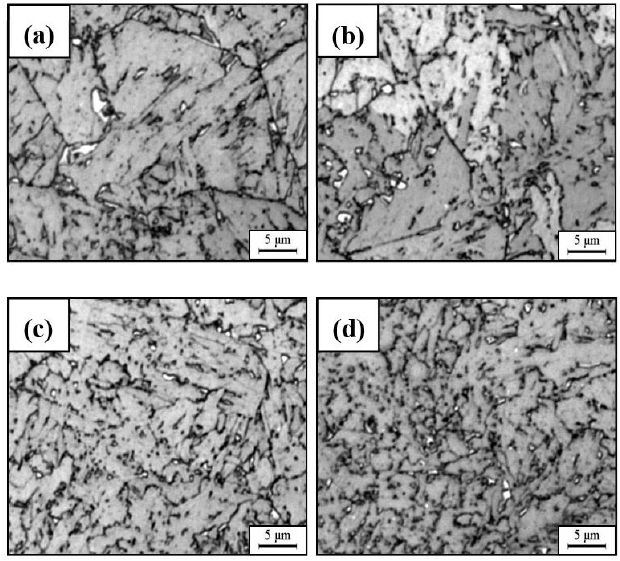
Figure 8. The M/A constituent observations at different finish rolling temperatures etched by the Lepera’s reagent: ( a ) 850 °C; ( b ) 830 °C; ( c ) 810 °C and ( d ) 790 °C. Ferrite matrix is grey and M/A constituent is white. M/A—martensite/austenite.